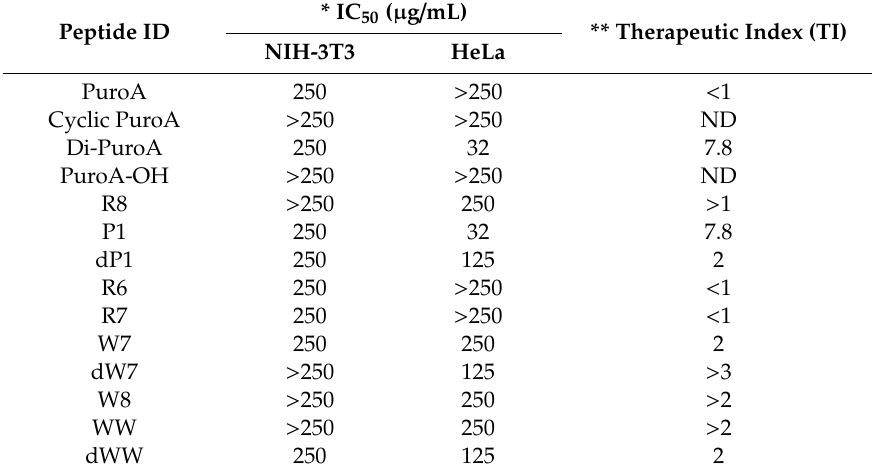
Table 5. Cytotoxicity of peptides to NIH-3T3 and HeLa cells.